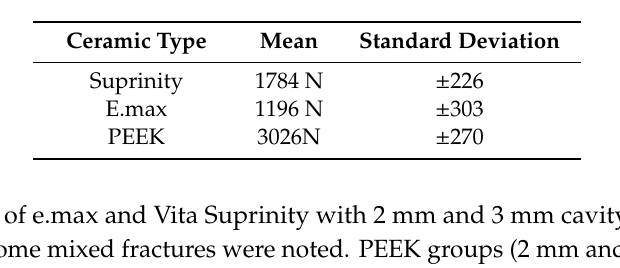
Table 1. Mean values and standard deviations of fracture resistance in Newtons (N) for test